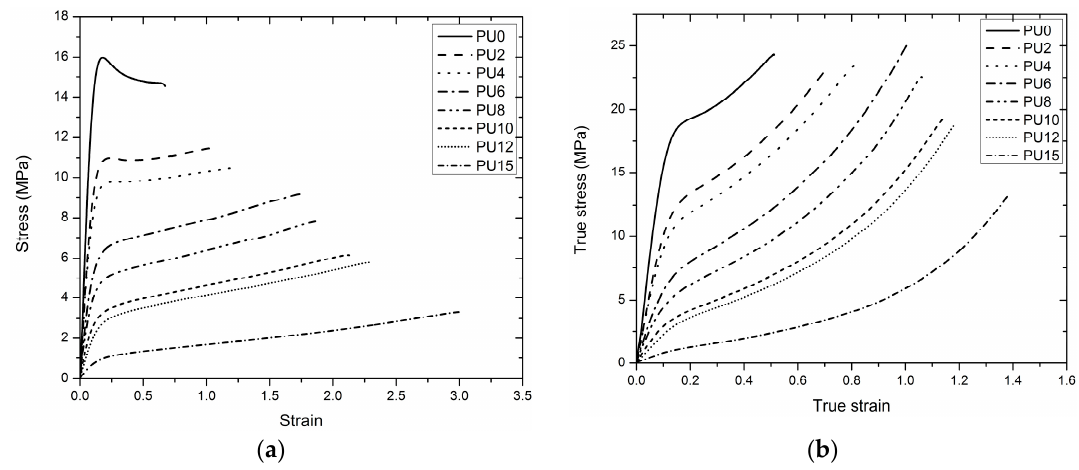
Figure 6. Tensile stress–strain behavior ( a ) engineering, ( b ) true, of the all types of PU, (PU0–PU15 are types of PU and PU6—PU which contained 6% PEG).